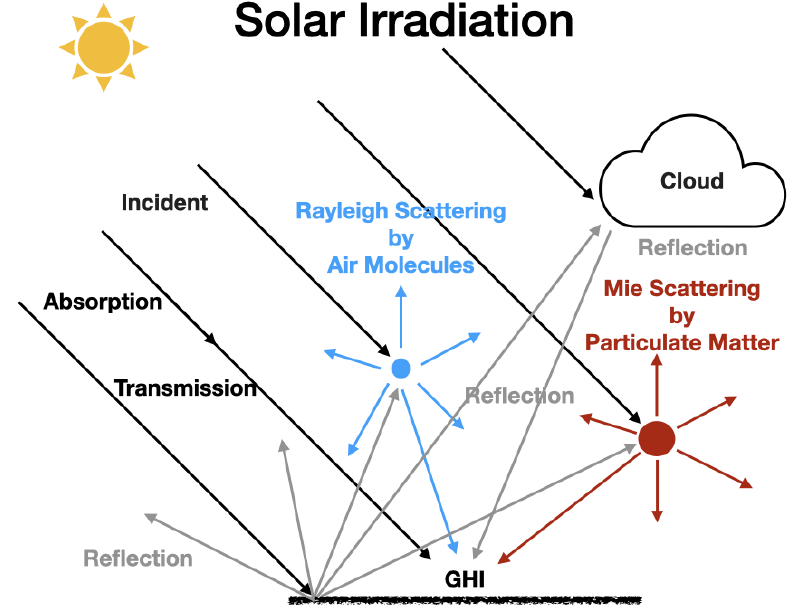
Figure 1. Solar irradiance on the Earth’s